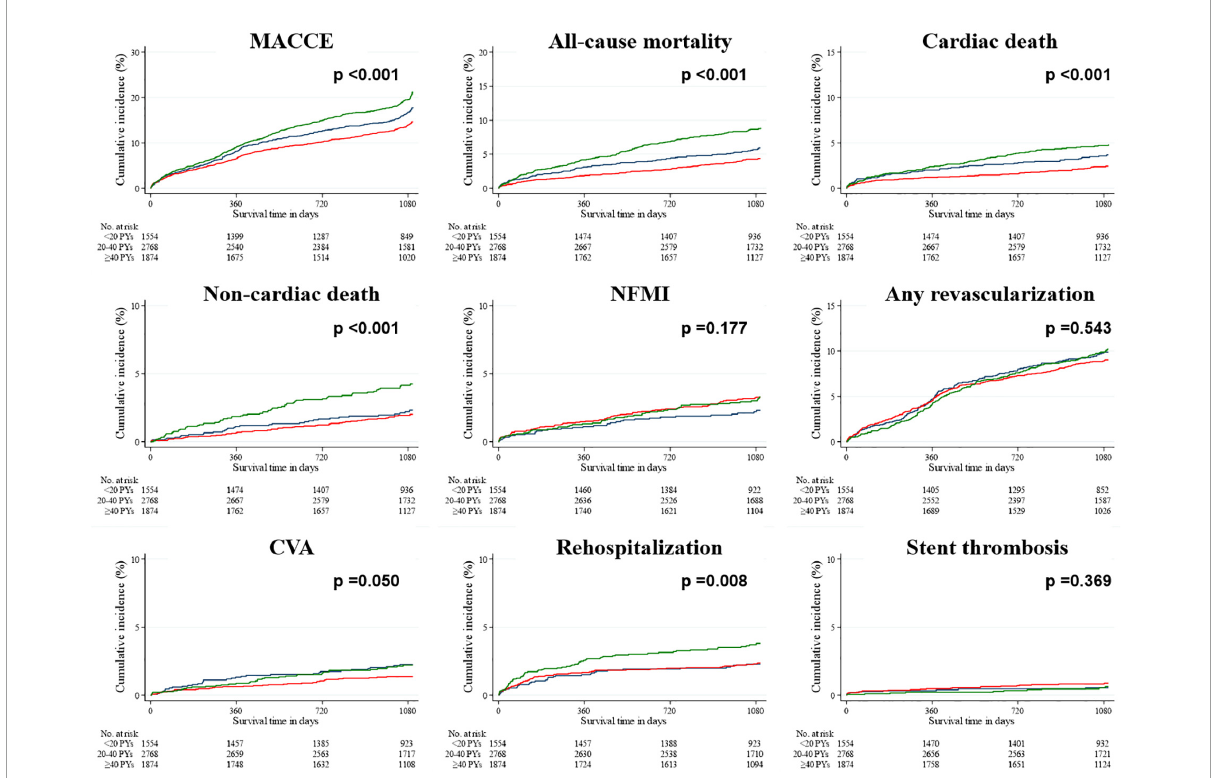
FIGURE2 Rates of primary and secondary outcomes for the smoking population after a 3-year follow-up (before IPTW adjustment). The Kaplan–Meier survival curves for cumulative event rates are illustrated according to the baseline smoking status. Blue line indicates the group with < 20 PYs. Red line indicates the group with 20–40 PYs. Green line indicates the group with ≥ 40 PYs. CVA, cerebrovascular accident; IPTW, inverse probability of treatment weighting; MACCE, major adverse cardiac and cerebrovascular event; NFMI, non-fatal myocardial infarction; PY, pack